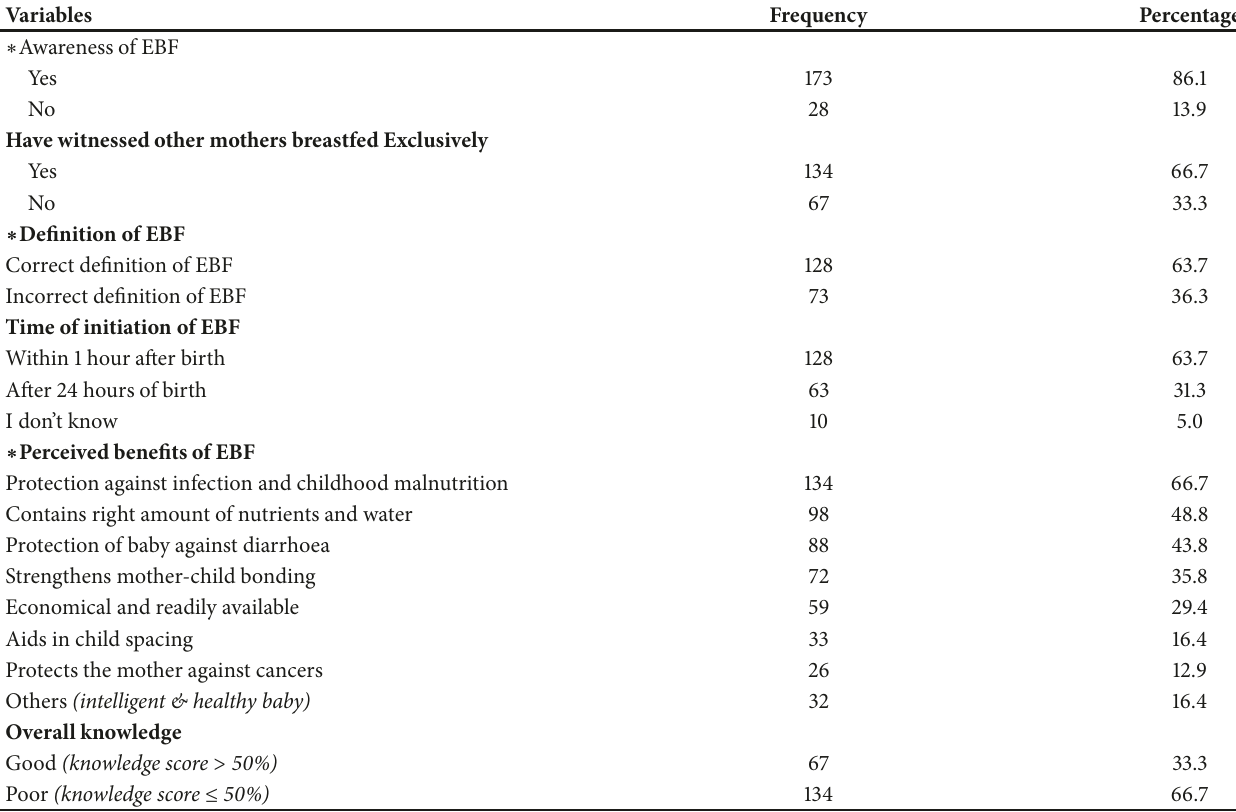
Table 2: Knowledge of exclusive breastfeeding (n = 201).